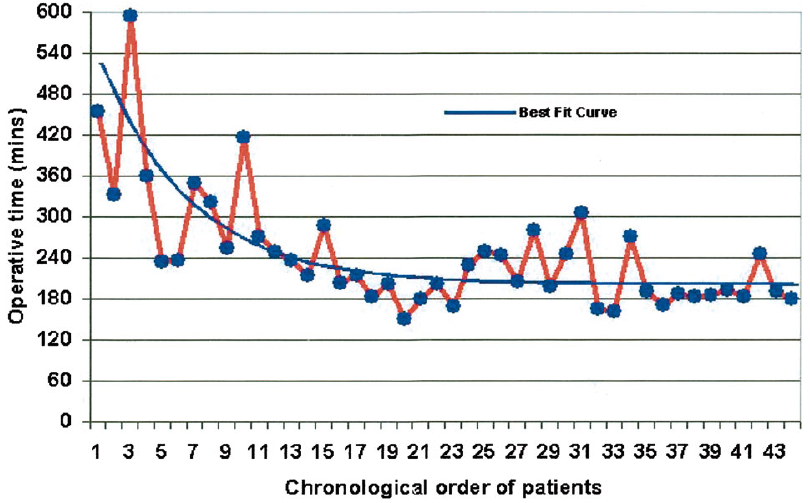
FIGURE 5. Operative times for robotic-assisted radical prostatectomy at the University of California at Irvine. (Figure reprinted from Surgical Endoscopy 18(12), 1694–1711, 2004. With kind permission of Springer Science and Business